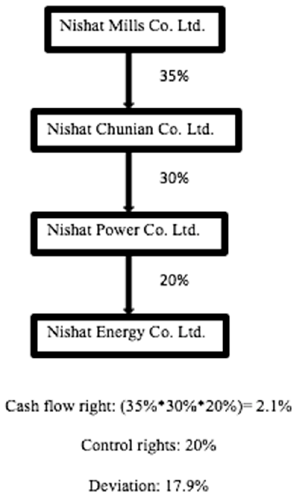
Figure A1. Typical pyramid structure in Pakistan.